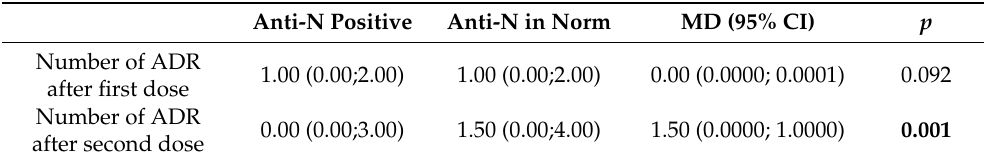
Table 6. Comparison of number of ADR between anti-N positive and anti-N in norm patients. Anti-N Positive Anti-N in Norm MD (95% CI) p Number of ADR 1.00 (0.00;2.00) 0.092 after first dose Number of